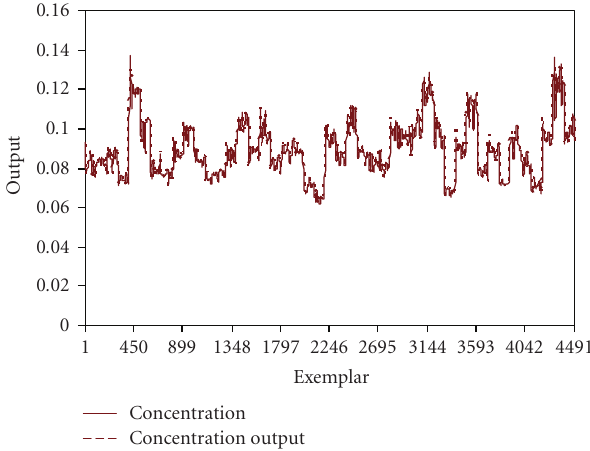
Figure 6: Desired output and Network output for testing data set (FTLR NN model-Benchmark data).